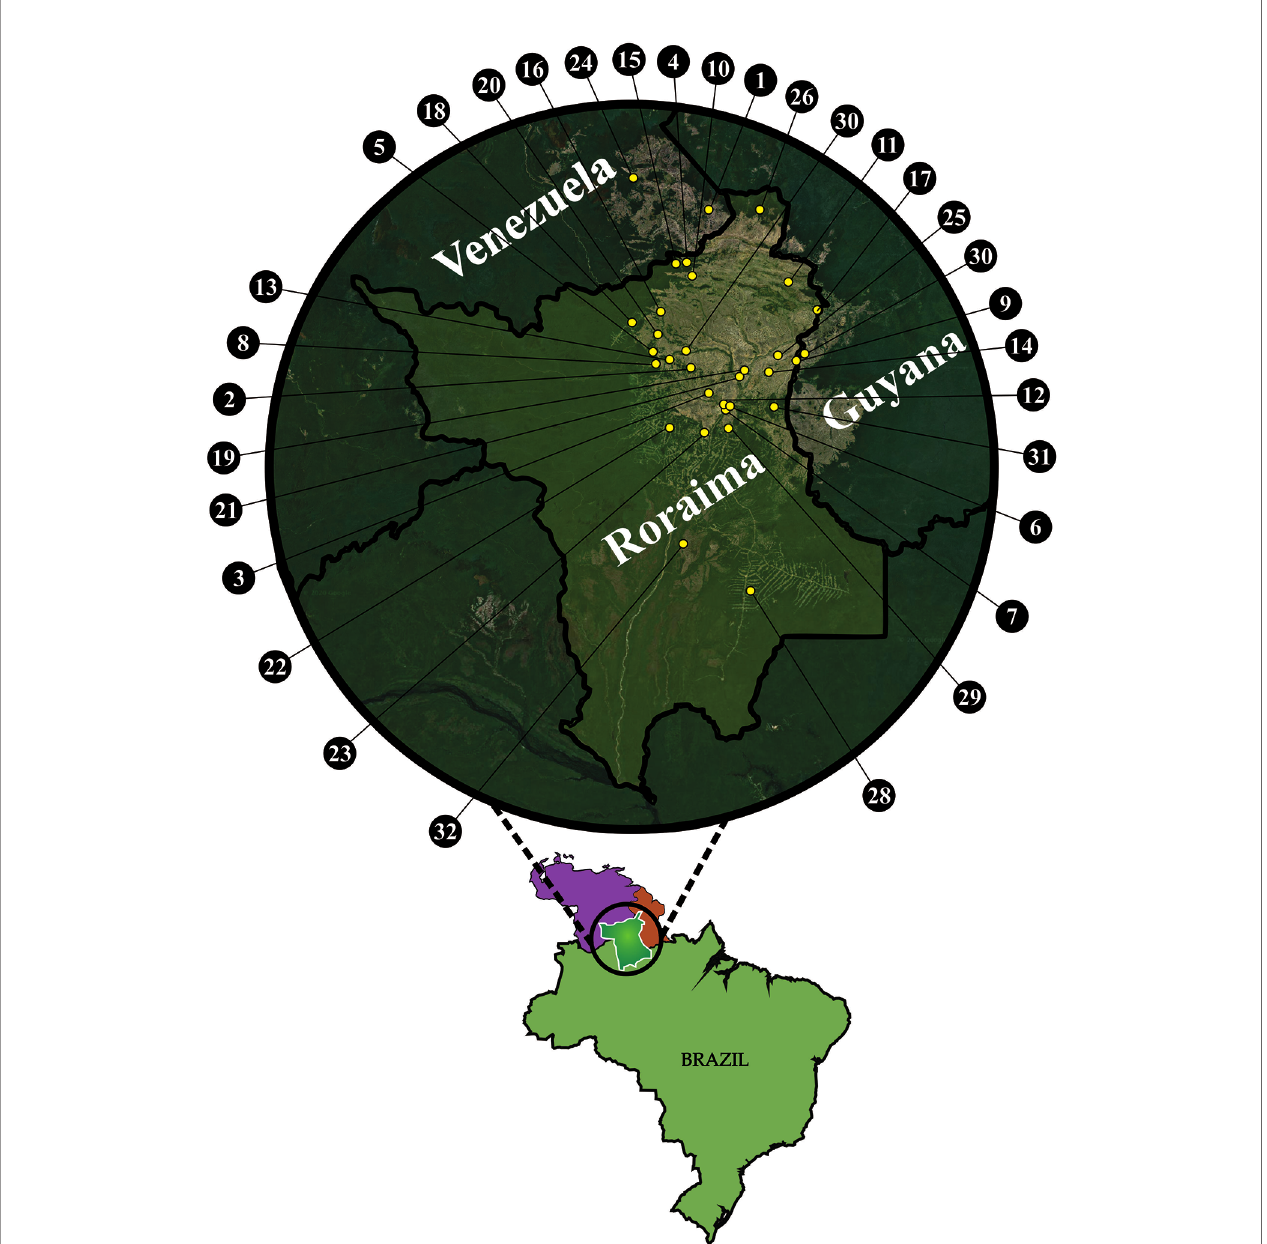
FIGURE 1 | Map with records of Crotalus durissus ruruima in Brazil (BR), Venezuela (VE), and Guyana (GU): 1 - Paulo Camp., Mount Roraima, VE (5°00 ’ N;60° 52 ’ W) (21); 2 - Taiano, Alto Alegre, RR, BR (3°15 ’ N;61°04 ’ W) (21); 3 - Bom Intento Farm, Boa Vista, RR, BR (2°58 ’ N;60°52 ’ W) (14); 4 -Pacaraima, RR, BR (4° 25 ’ N; 61°08 ’ W) (21); 5 - Maraca ́ Island, RR, BR (03°25 ’ N; 61°29 ’ W) (18); 6 - Boa Vista, RR, BR (02°49 ’ N;60°39 ’ W) (21); 7 - 7° BIS, Boa Vista, RR, BR (02° 47 ’ N; 60°41 ’ W) (21); 8 - Maloca Mangueira, Alto Alegre, RR, BR (03°18 ’ N;61°27 ’ W) (21); 9 - Bon fi m, RR, BR (03°21 ’ N;59°49 ’ W) (21); 10 - Surumu River, RR, BR (04°16 ’ N;61°03 ’ W) (21); 11 - Maloca Boqueirão, Alto Alegre, RR, BR (04°12 ’ N; 59°59 ’ W) (21); 12 - Monte Cristo Farm, Boa Vista, RR, BR (02°51 ’ N; 60° 42 ’ W) (21); 13 - Salvamento Farm, Alto Alegre, RR, BR (03°20 ’ N; 61°18 ’ W) (21); 14 - Igarape ́ Garrafa, Boa Vista, RR, BR (03°12 ’ N; 60°12 ’ W) (21); 15 - Sorocaima, RR, BR (04°25 ’ N; 61°11 ’ W) (21); 16 - Tre ̂ s Corac ̧ ões, RR, BR (03°52 ’ N; 61° 24 ’ W) (this study); 17 - Normandia, RR, BR (03°51 ’ N, 59°35 ’ W) (14); 18 - Tepeque ́ m, RR, BR (03°45 ’ N; 61°43 ’ W) (21); 19 - Campo Alegre, Boa Vista, RR, BR (3°16 ’ 31.7 ” N 60°31 ’ 27.0 ” W) (14); 20 - Amajari, RR, BR (03°37 ’ N; 61° 26 ’ W) (21); 21 - Passarão, Boa Vista, RR (03°11 ’ N;60°35 ’ W) (14); 22 - Apiau ́ , Alto Alegre, RR, BR (02°35 ’ N;61°18 ’ W) (14); 23 - Mucaja ı ́ , RR, BR (02°32 ’ N;60° 55 ’ W) (14); 24 - Carima ́ n-Paru, Gran Sabana, VE (0521N; 6142W) (4); 25 - Bon fi m, RR, BR (03°23 ’ N; 60°06 ’ W) (14); 26 – Uiramutã, RR, BR (4°60 ’ , 60.18 ’ W) (21); 27 - Colo ̂ nia Coronel Mota em Taiano, Alto Alegre, RR, BR (03 °26 ’ N, 61.07 ’ W) (21); 28 - Roraino ́ polis, RR, BR (0°46 ’ 27.7 ” N 60°24 ’ 13.6 ” W) (21); 29 - Vila Serra Grande, Canta ́ (this study), RR, BR (2°34 ’ 47 ’’ N 60°38 ’ 57 ’’ W); 30 – Lethem, GU (3°22 ’ 59 ’’ N 59°48 ’ 17 ’’ W) (14); 31 - São Francisco Village, Bon fi m, RR, BR (2° 48 ’ 58 ’’ N 60°08 ’ 34 ’’ W) (this study); 32 - Virua ́ National Park – Caracara ı ́ , RR, BR (1°17 ’ 39.3 ” N 61°09 ’ 04.6 ” W) (21). Georeferencing was made with QGis software and the fi nal fi gure was prepared using